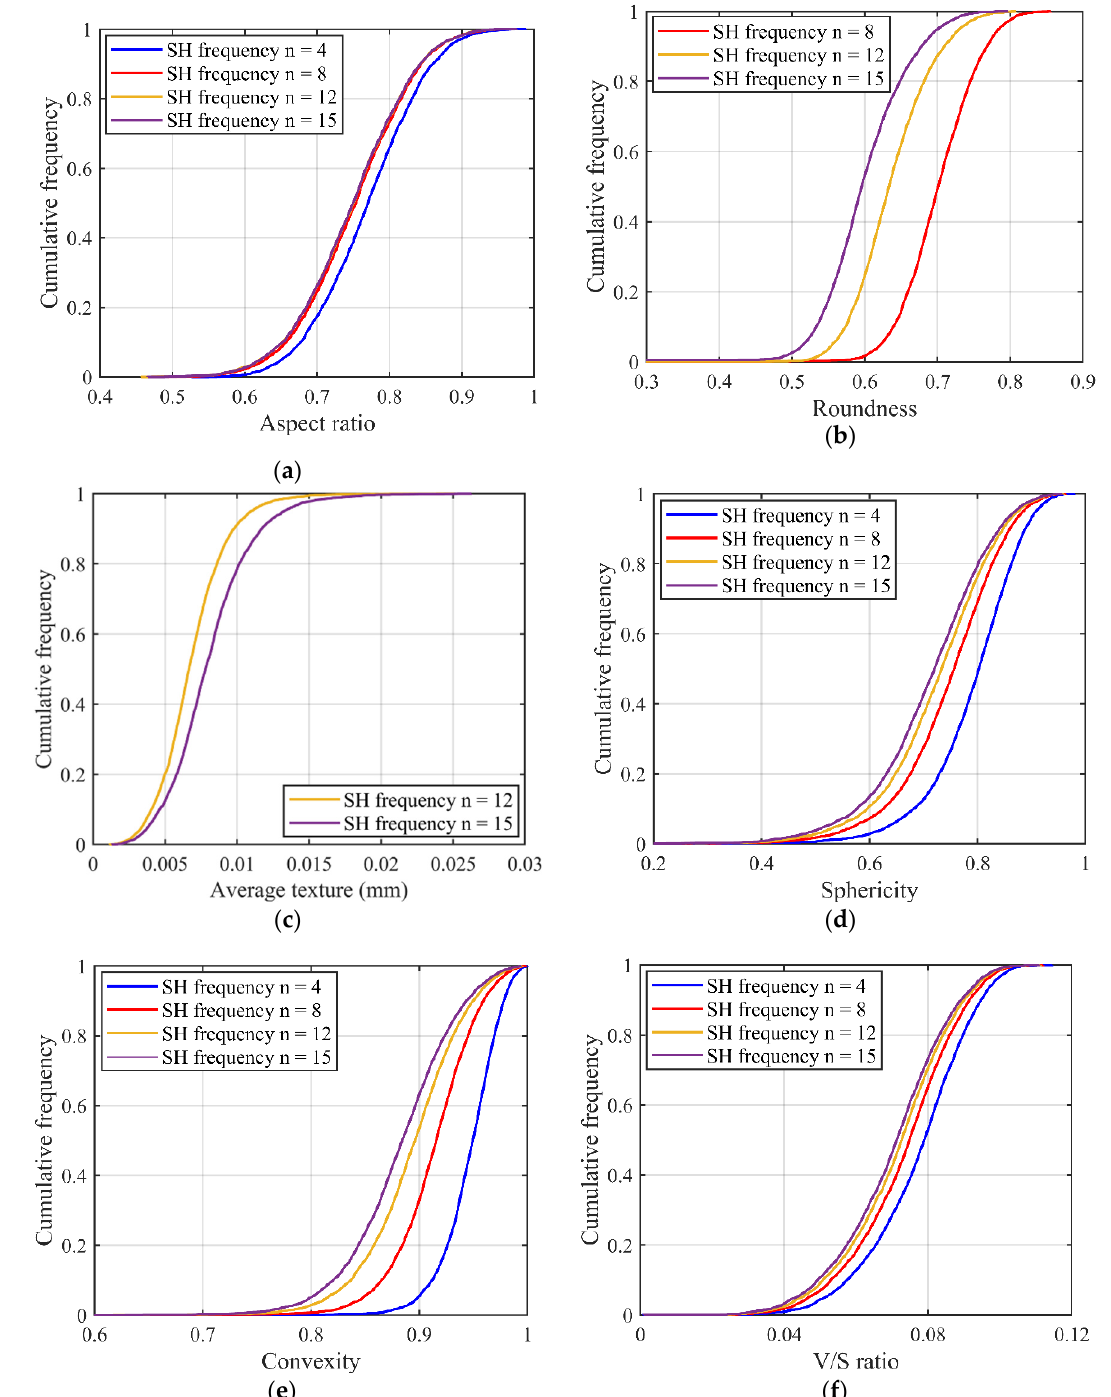
Figure 4. Variation of particle morphology descriptors with SH frequency: ( a ) aspect ratio; ( b ) Figure4. VariationofparticlemorphologydescriptorswithSHfrequency: ( a )aspectratio; ( b )roundness; roundness; ( c ) average texture; ( d ) sphericity; ( e ) convexity; ( f ) V/S ratio. ( c ) average texture; ( d ) sphericity; ( e ) convexity; ( f ) V / S